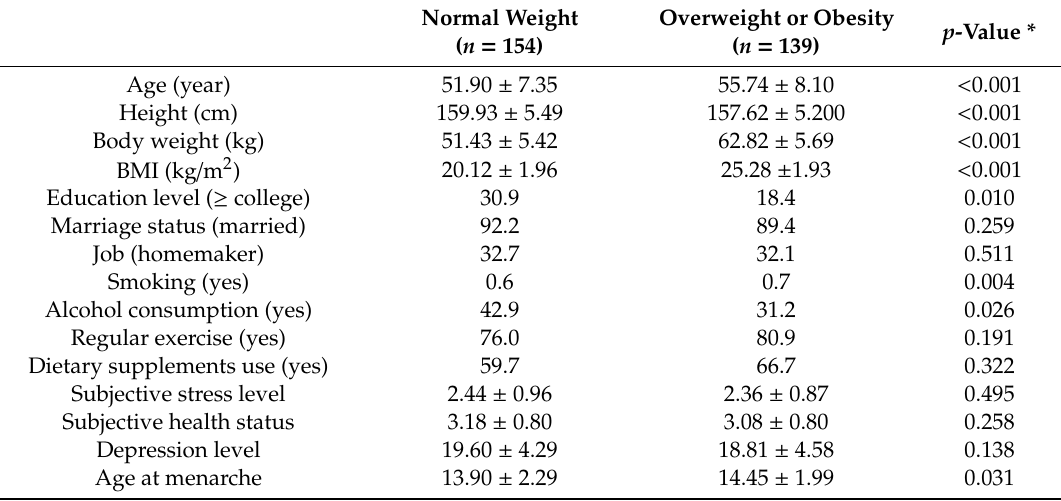
Table 1. Demographic characteristics and health-related variables according to body mass index (BMI) categories.